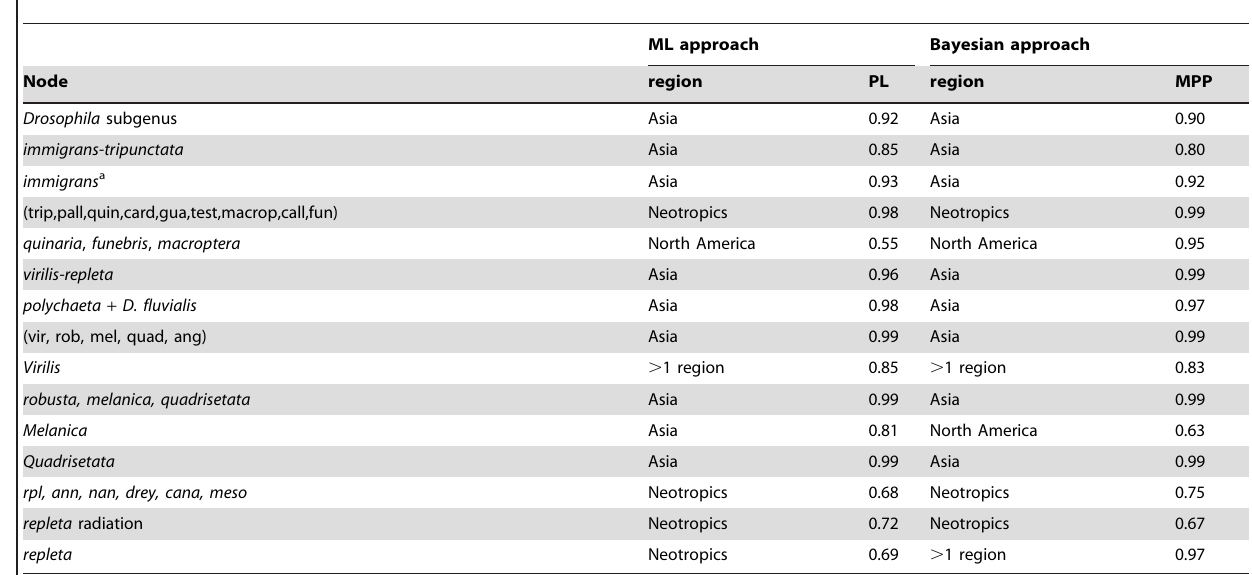
Table 2. Ancestral biogeographic reconstructions obtained with Likelihood (ML) and Bayesian